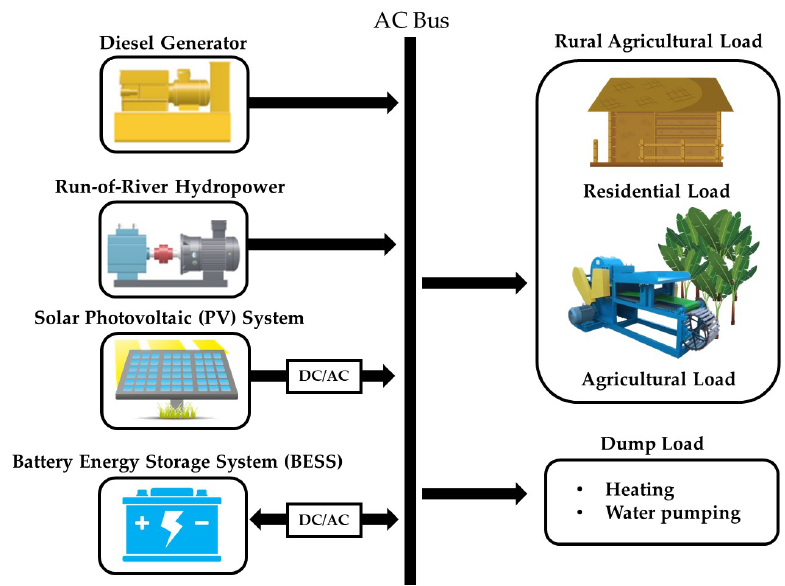
Figure 5. Proposed HREM model schematic